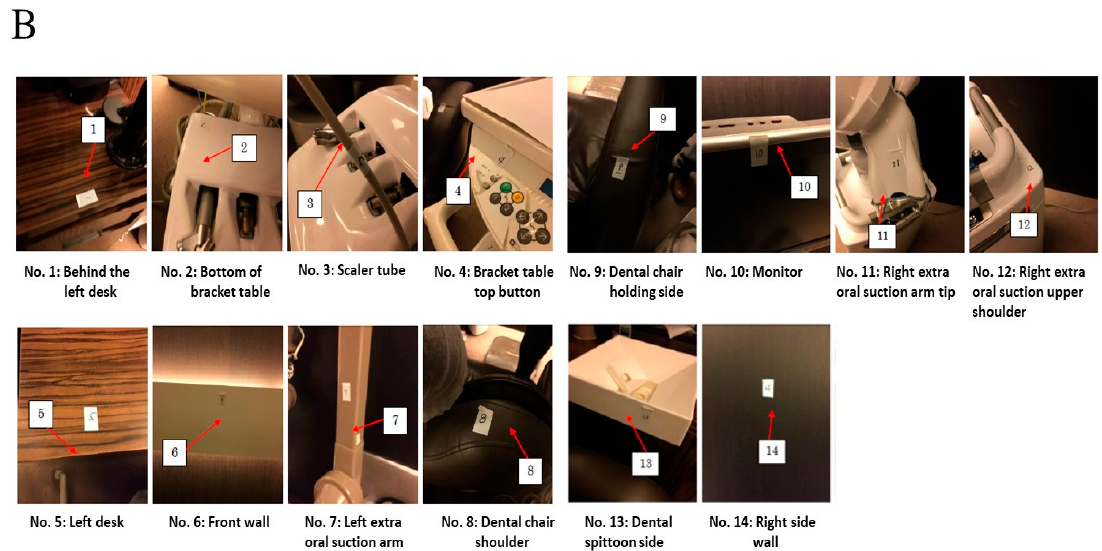
Figure 2. Sampling areas of droplets and aerosols for the detection of RLU. Numbers (1~14) in the picture indicate the locations of sampling areas that were swabbed by the LuciPac pen around the dental chair. ( A ): Whole photo, ( B ): Photographs of individual parts. A volunteer provided consent to share the picture.